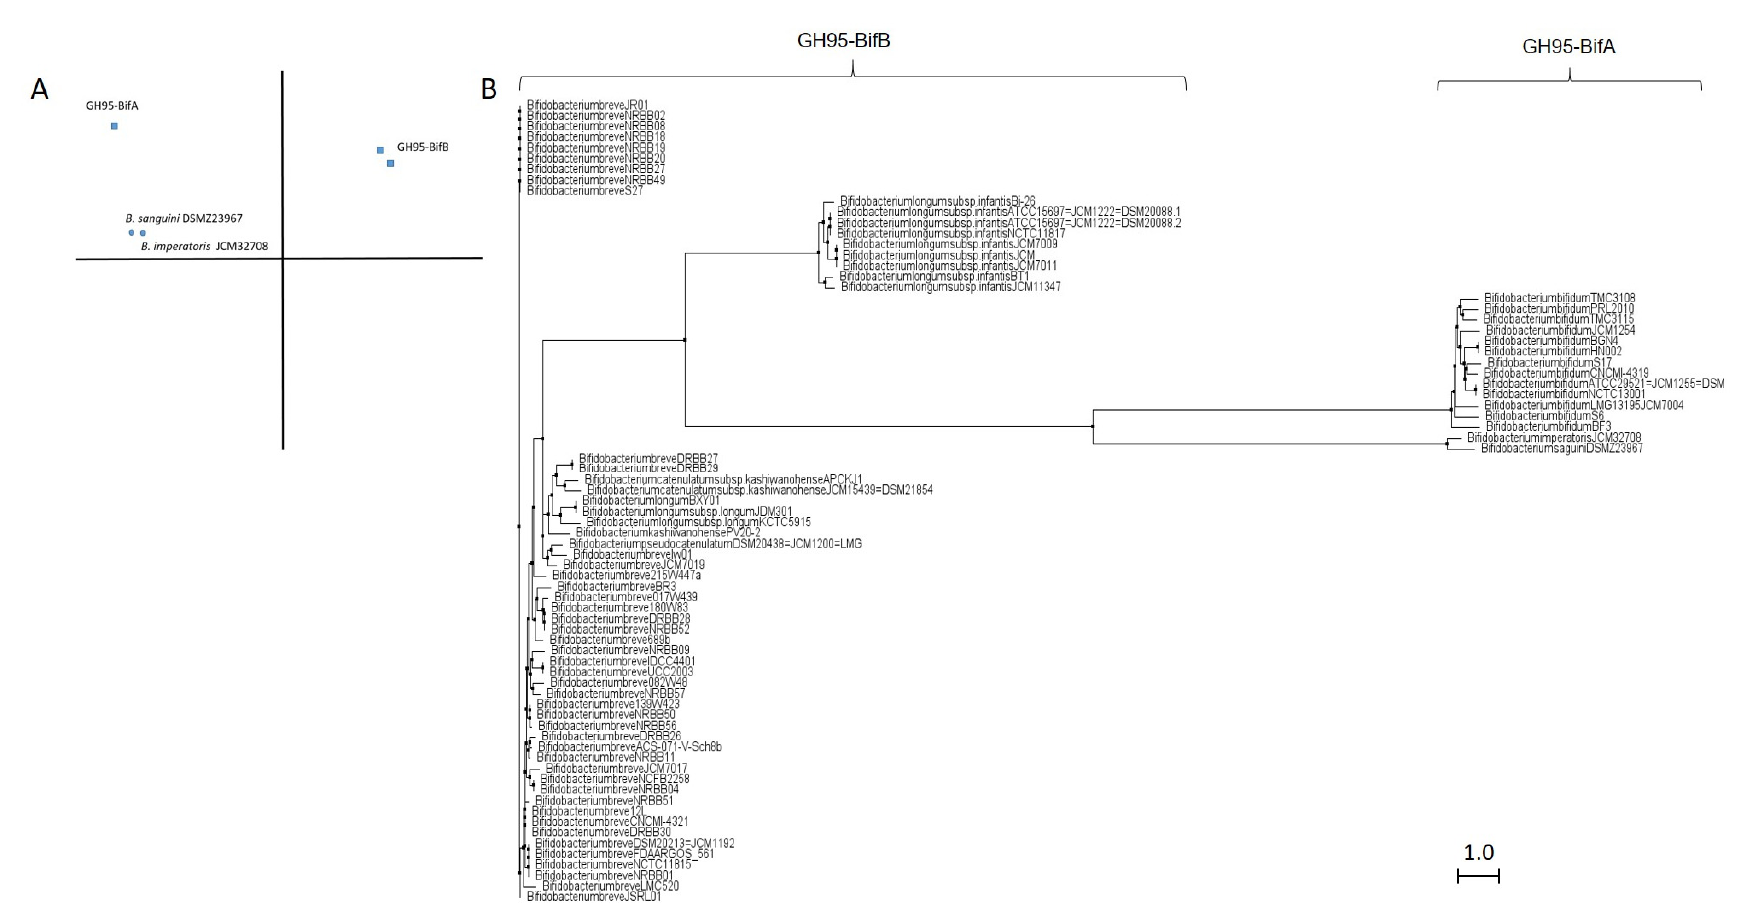
Figure 3. Phylogenetic analysis of bifidobacterial GH95 fucosidases. PCA ( A ) and cladogram tree ( B ) distributions of bifidobacterial GH95 fucosidase sequences listed in CAZy, released from Jalview 2.11.1.4 software using the neighbor-joining method.